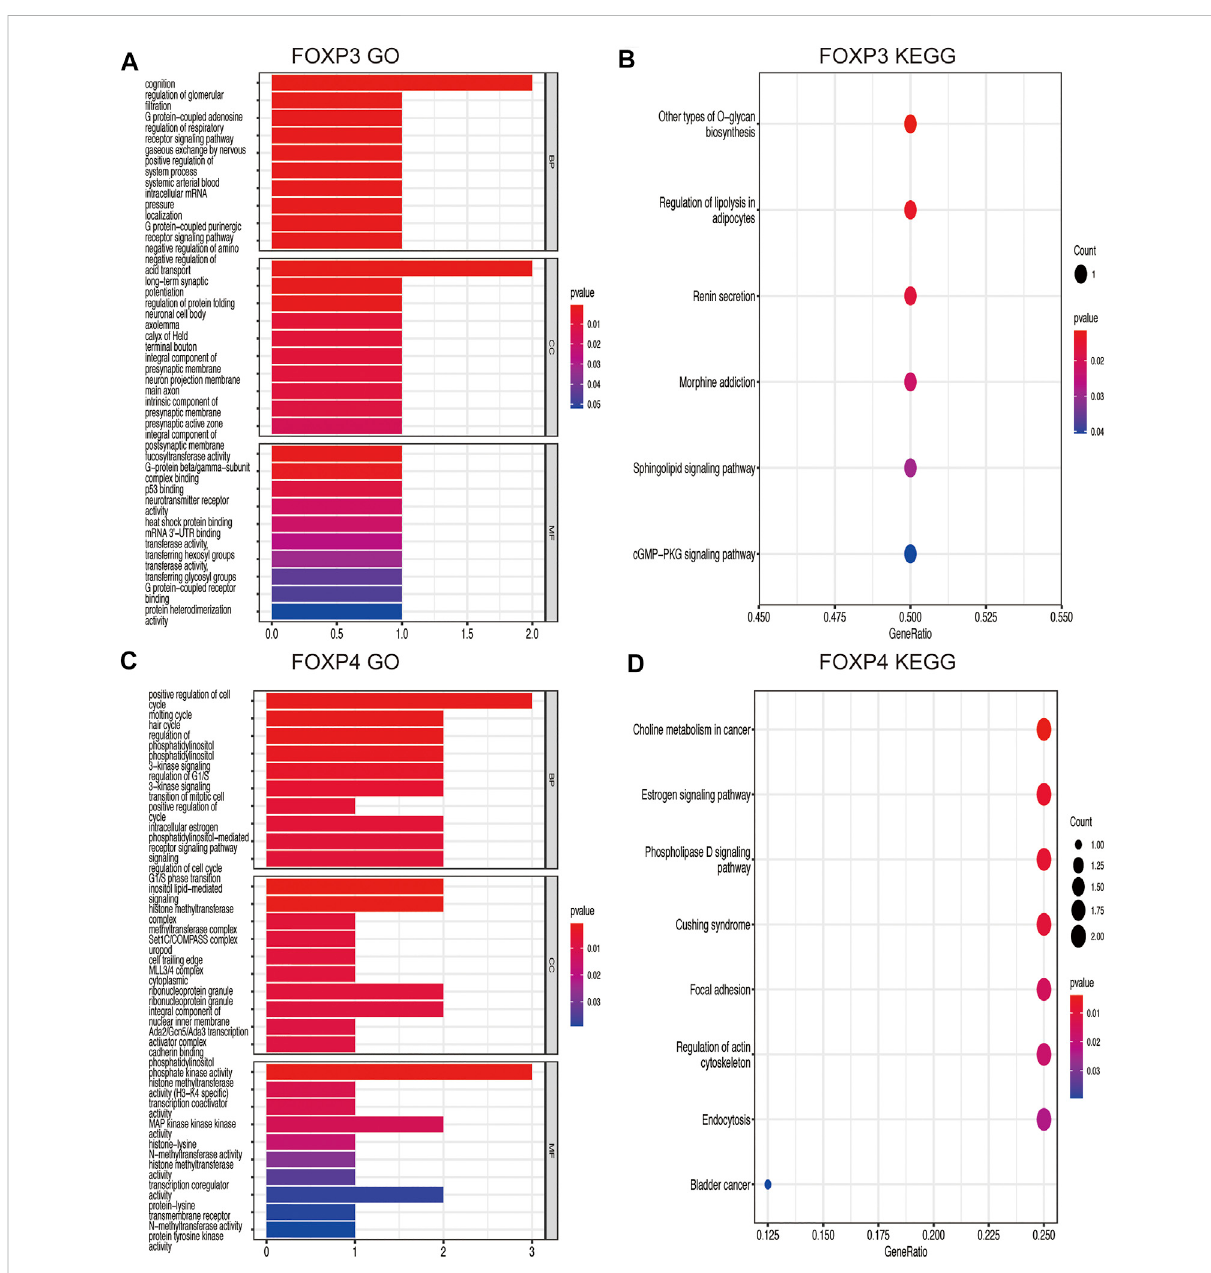
FIGURE 7 GO functional enrichment analysis and KEGG pathway enrichment analysis are performed on the coexpressed genes. (A) The result of GO functional enrichment analysis on the coexpressed genes of FOXP3. (B) The result of KEGG pathway enrichment analysis on the coexpressed genes of FOXP3. (C) The result of GO functional enrichment analysis on the coexpressed genes of FOXP4. (D) The result of KEGG pathway enrichment analysis on the coexpressed genes of